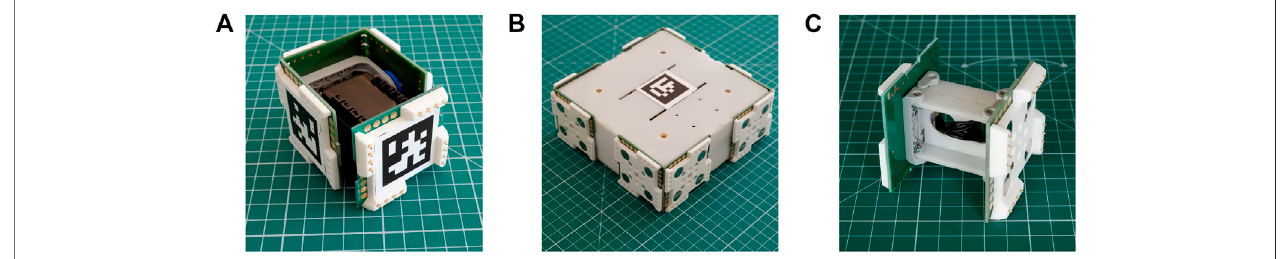
FIGURE 2 | EMERGE modules (A) The active EMERGE module (B) the base module and (C) the link module. The modules can be connected together to build robots with different morphologies. Their magnetic connections allow a quick assembly of the modules, which is useful to test evolved morphologies and controllers. Fiducial markers make them easy to track by an automatic